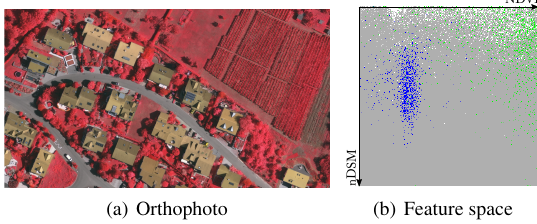
Figure 3: Orthophoto and feature space for patch 17. Colours: ground (white), building (blue) and tree (green).